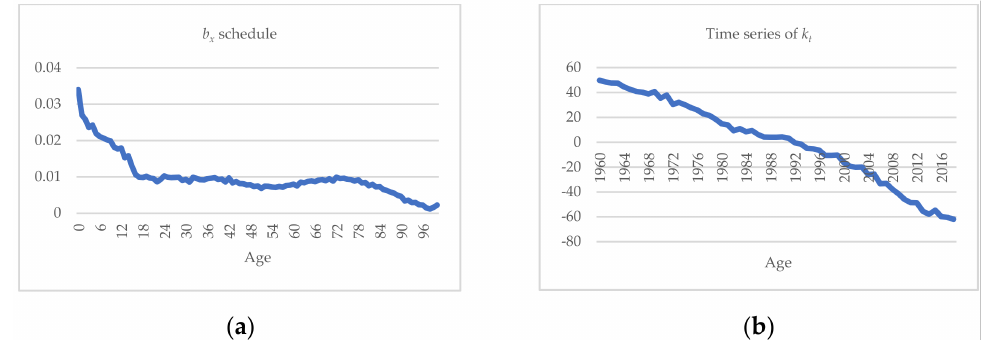
Figure 3. ( a ) Age parameter b x for the Spanish population; ( b ) time parameter k t for the Spanish population. Source: